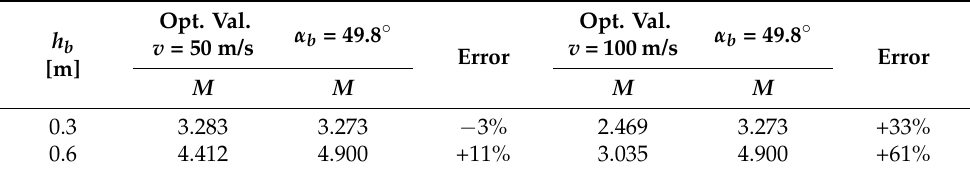
c , based on Table 3. z